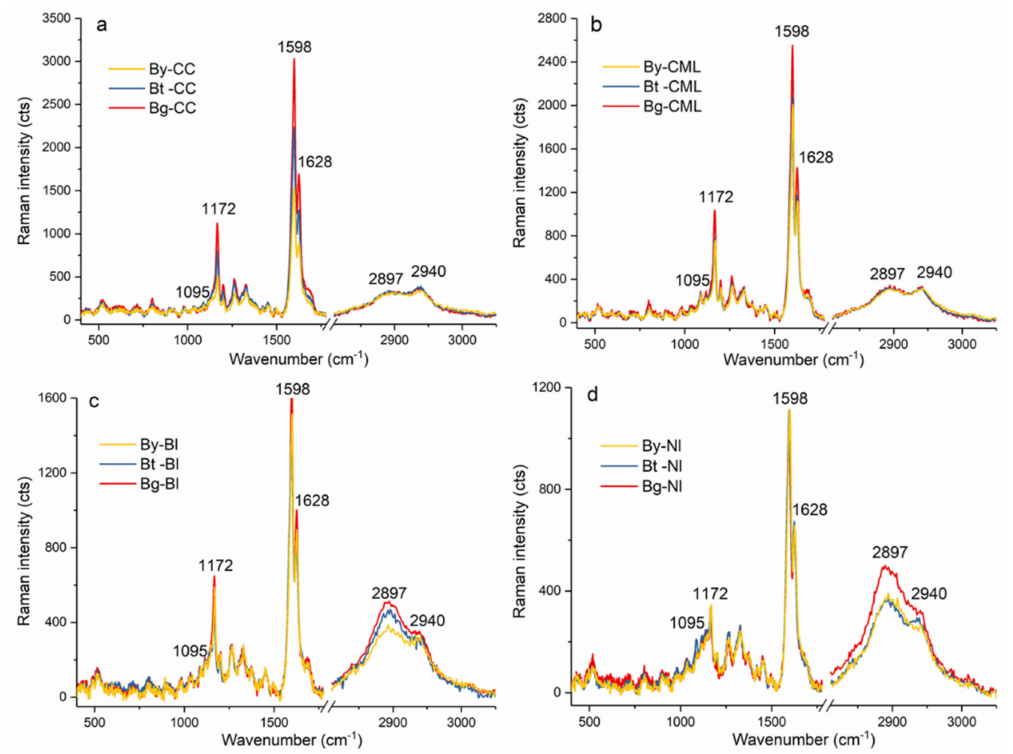
Figure 4. Average Raman spectra extracted from the CC ( a ), CML ( b ), Bl ( c ) and Nl ( d ) of fiber located at Bg, Bt and By.